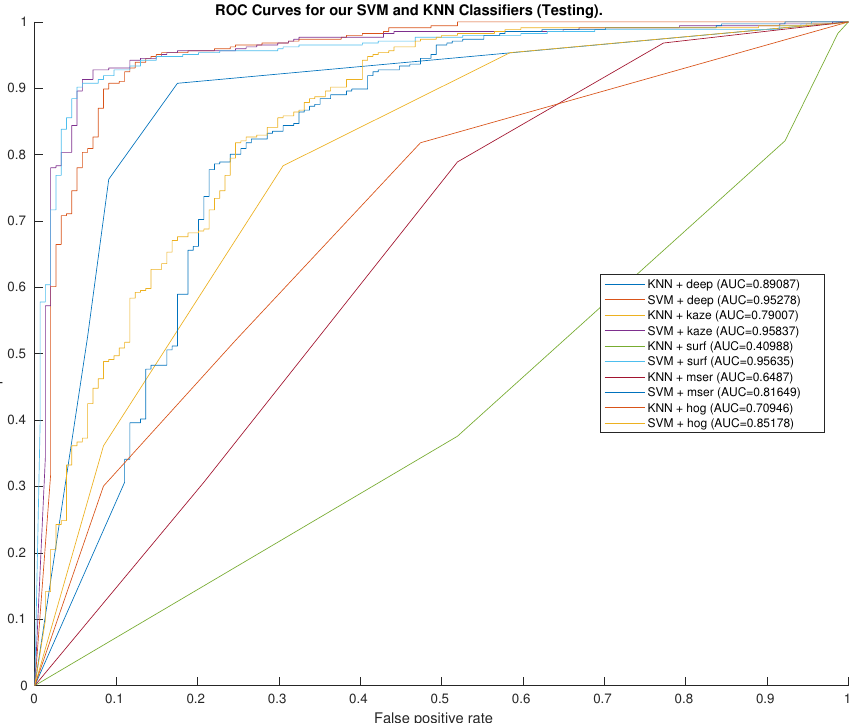
Figure 8. The Receiver Operating Characteristic curves for the proposed method and the evaluation methods on the test data set. The legend in the figure shows the respective Area Under the Curve for each